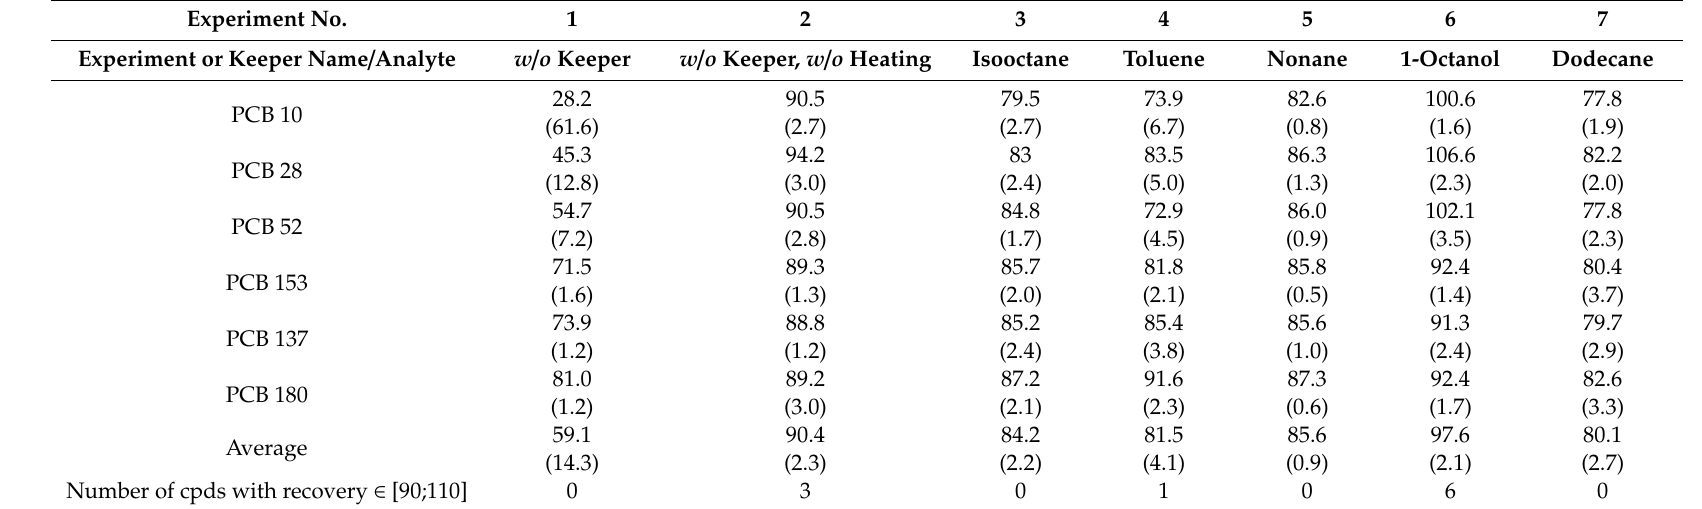
RSDs given in parentheses; w / o , without; cpds,